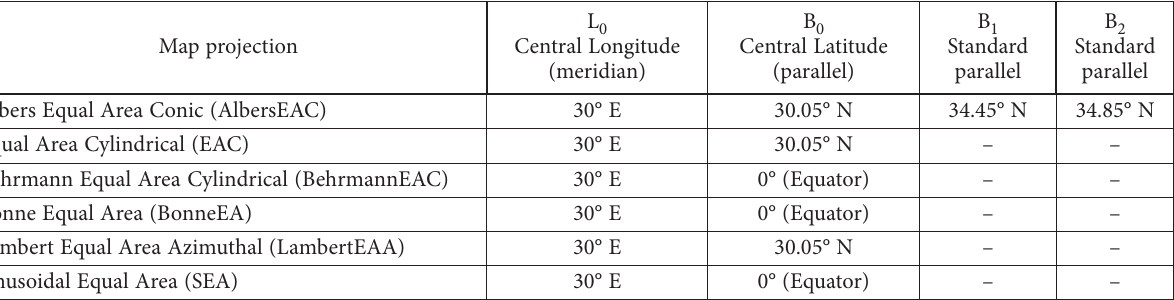
Table 2. Projections and projection parameters used in the